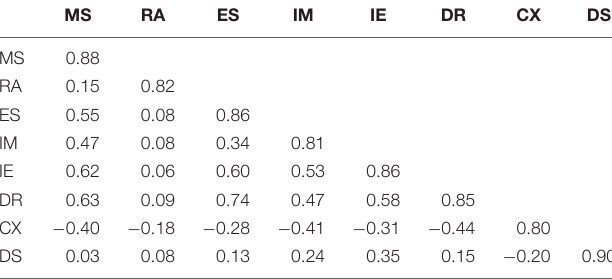
TABLE 9 | Discriminant validity (dependent variable: implementation effectiveness).